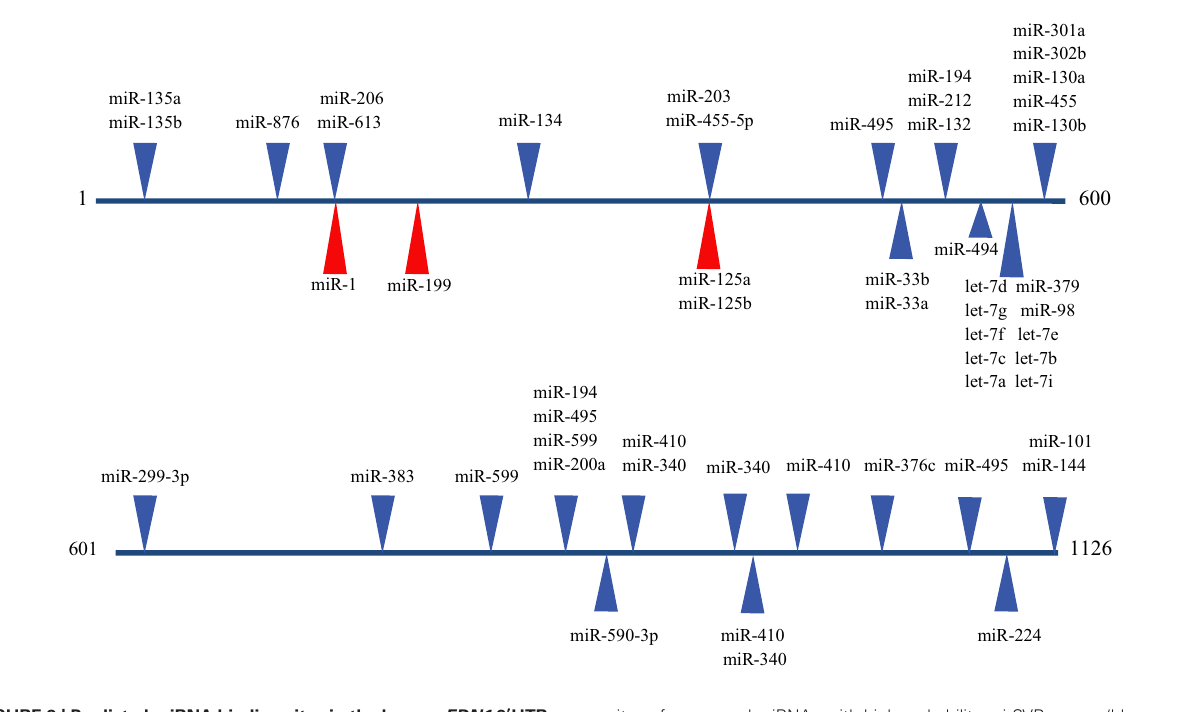
sites of conserved miRNAs with high probability mirSVR scores (blue arrows), and target sites for miRNAs empirically shown to interact with EDN1 mRNA (red